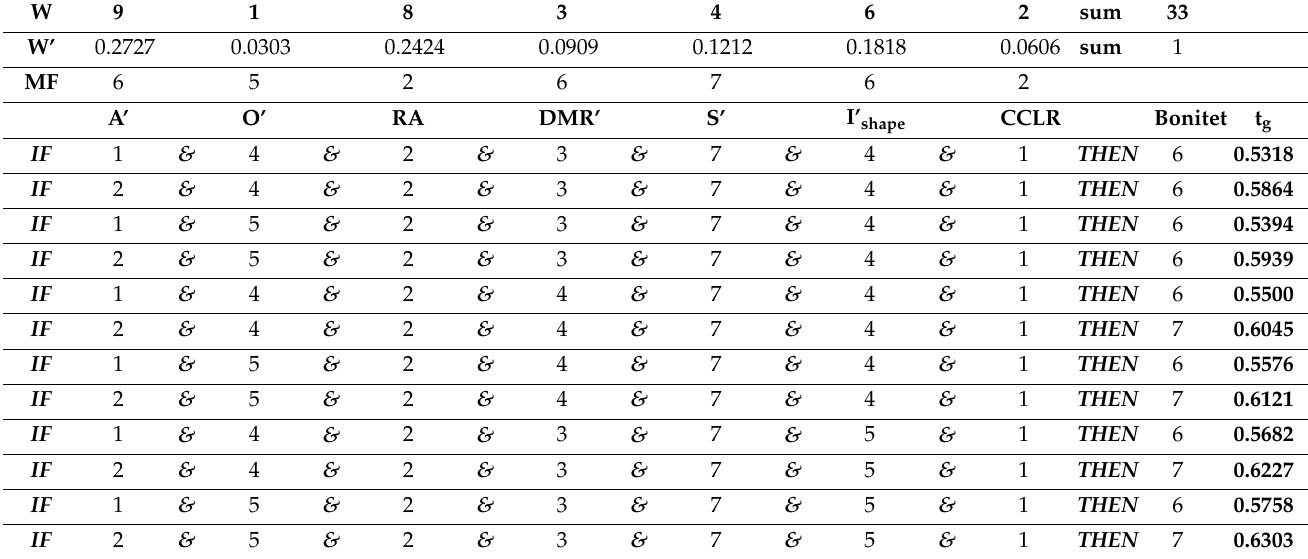
Table 10. Part of fuzzy rules with a definition of weighting coefficients (cadastral parcel